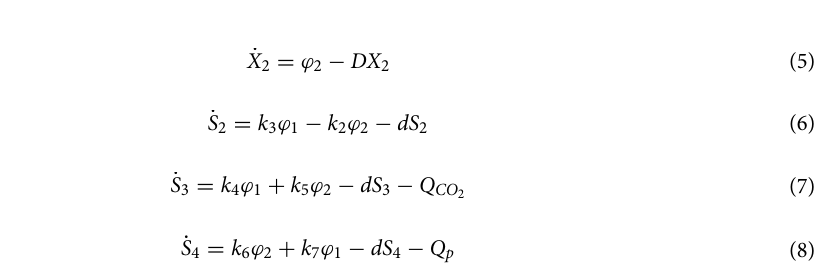
Figure 4. Scheme of the anaerobic digestion 3